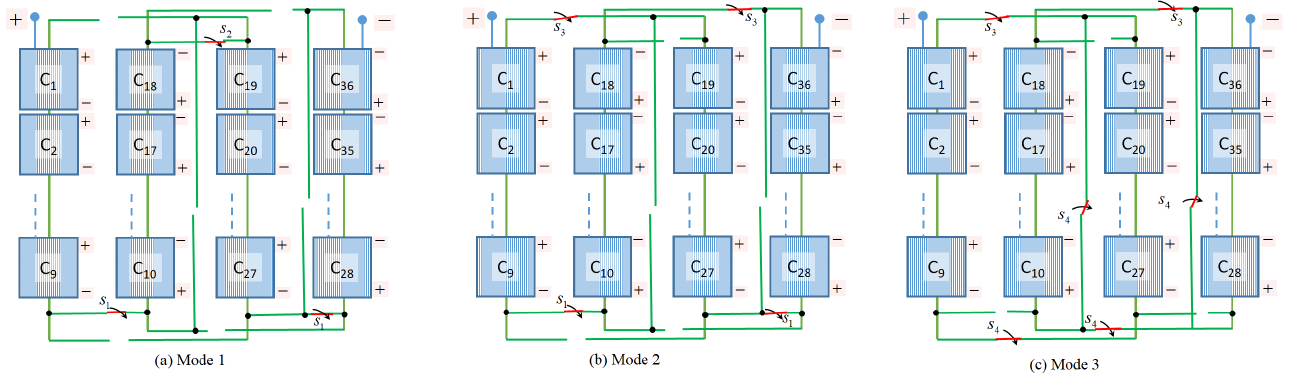
Figure 4. Different modes of operations for the proposed PV module, where the voltage and the current could be scaled based on the load’s electrical needs.